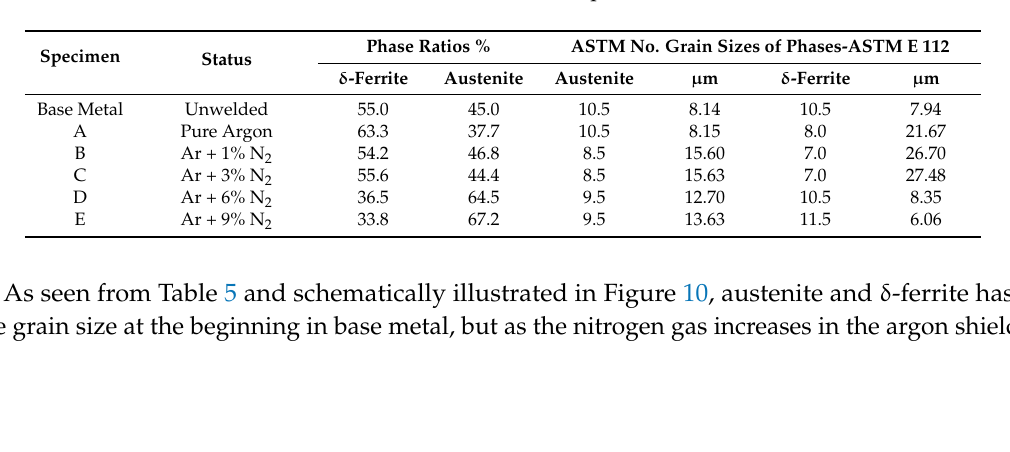
Figure 9. Determination of δ -ferrite phase grain size; upper figure: base metal ASTM 10.5, bottom figure: specimen welded with pure argon shielding gas, ASTM 8.0. The grain size evaluations of all specimens according to ASTM E112 standard by Kameram Software are shown in Table 5. Table 5. Grain sizes of all